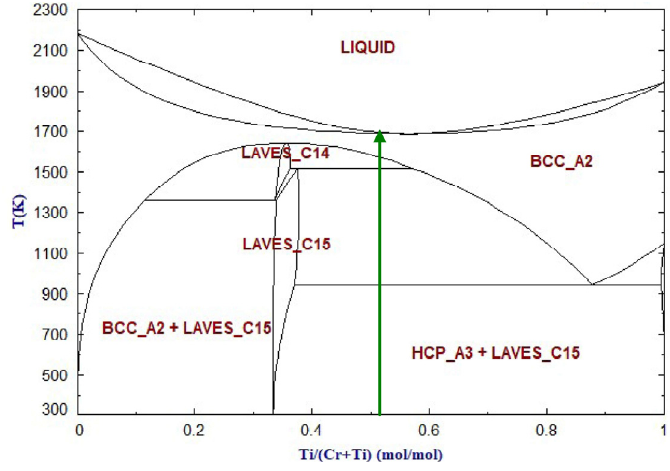
Figure 6. Ti-Cr phase diagram from FactSage 7.3 databases [33].